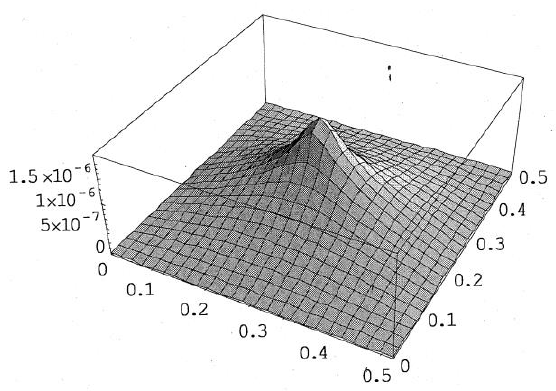
Figure 4. Deformed shape of the composite laminate plate induced by PZT actuator with dimensions of 40 mm × 60 mm × 0.5 mm.